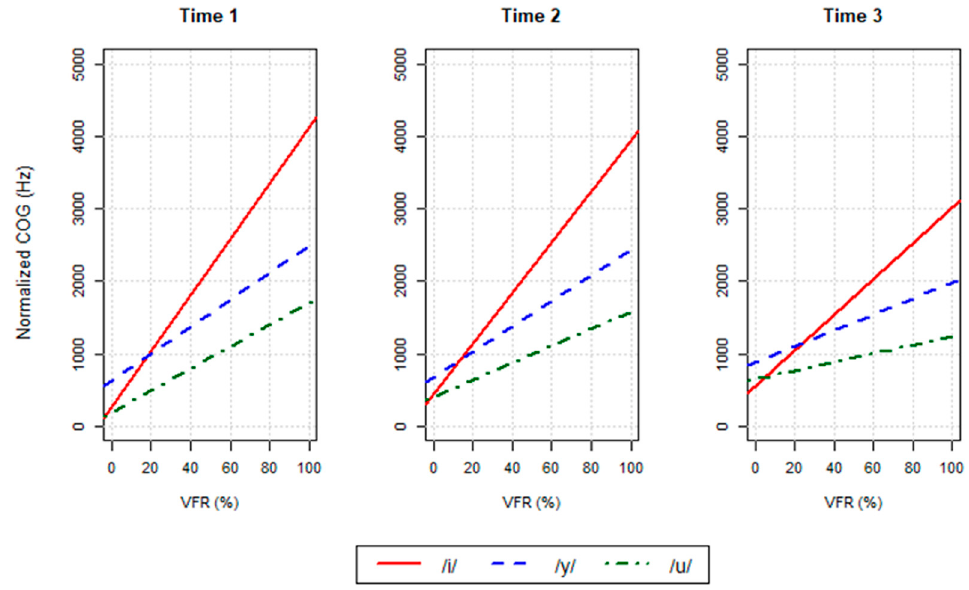
Figure 3. COG by vowel and FVR at all timepoints.